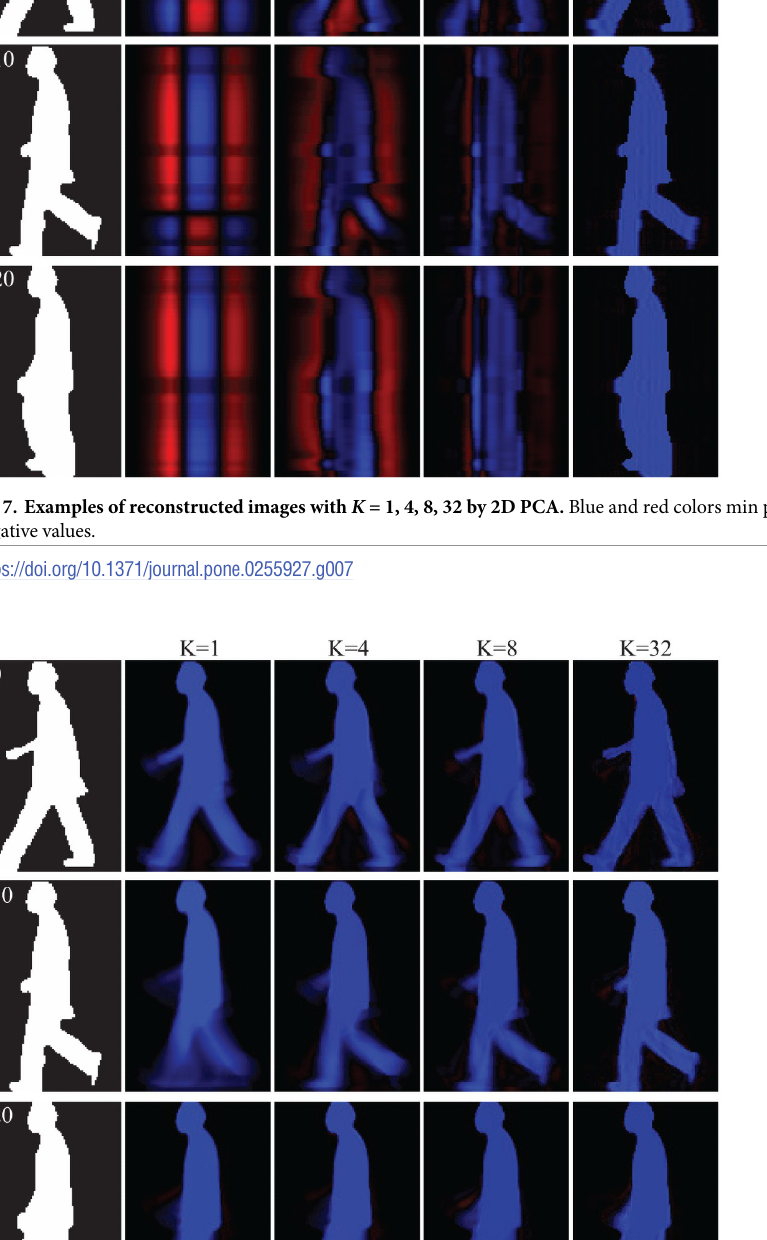
PLOS ONE | https://doi.org/10.1371/journal.pone.0255927 August 11,